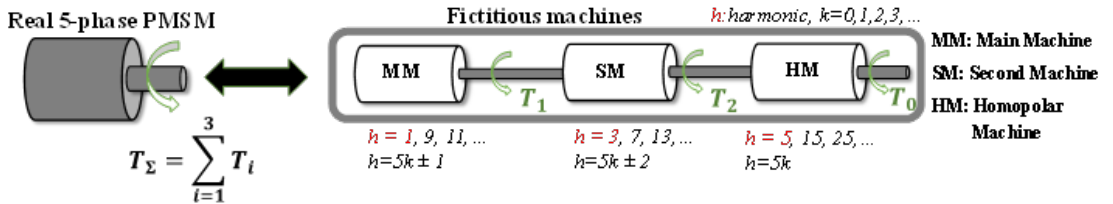
Figure 18. Waveform and harmonic spectrum of the back EMF of phase “a” of the highly non-sinus- oidal five-phase PMSM at 78 rad/s.